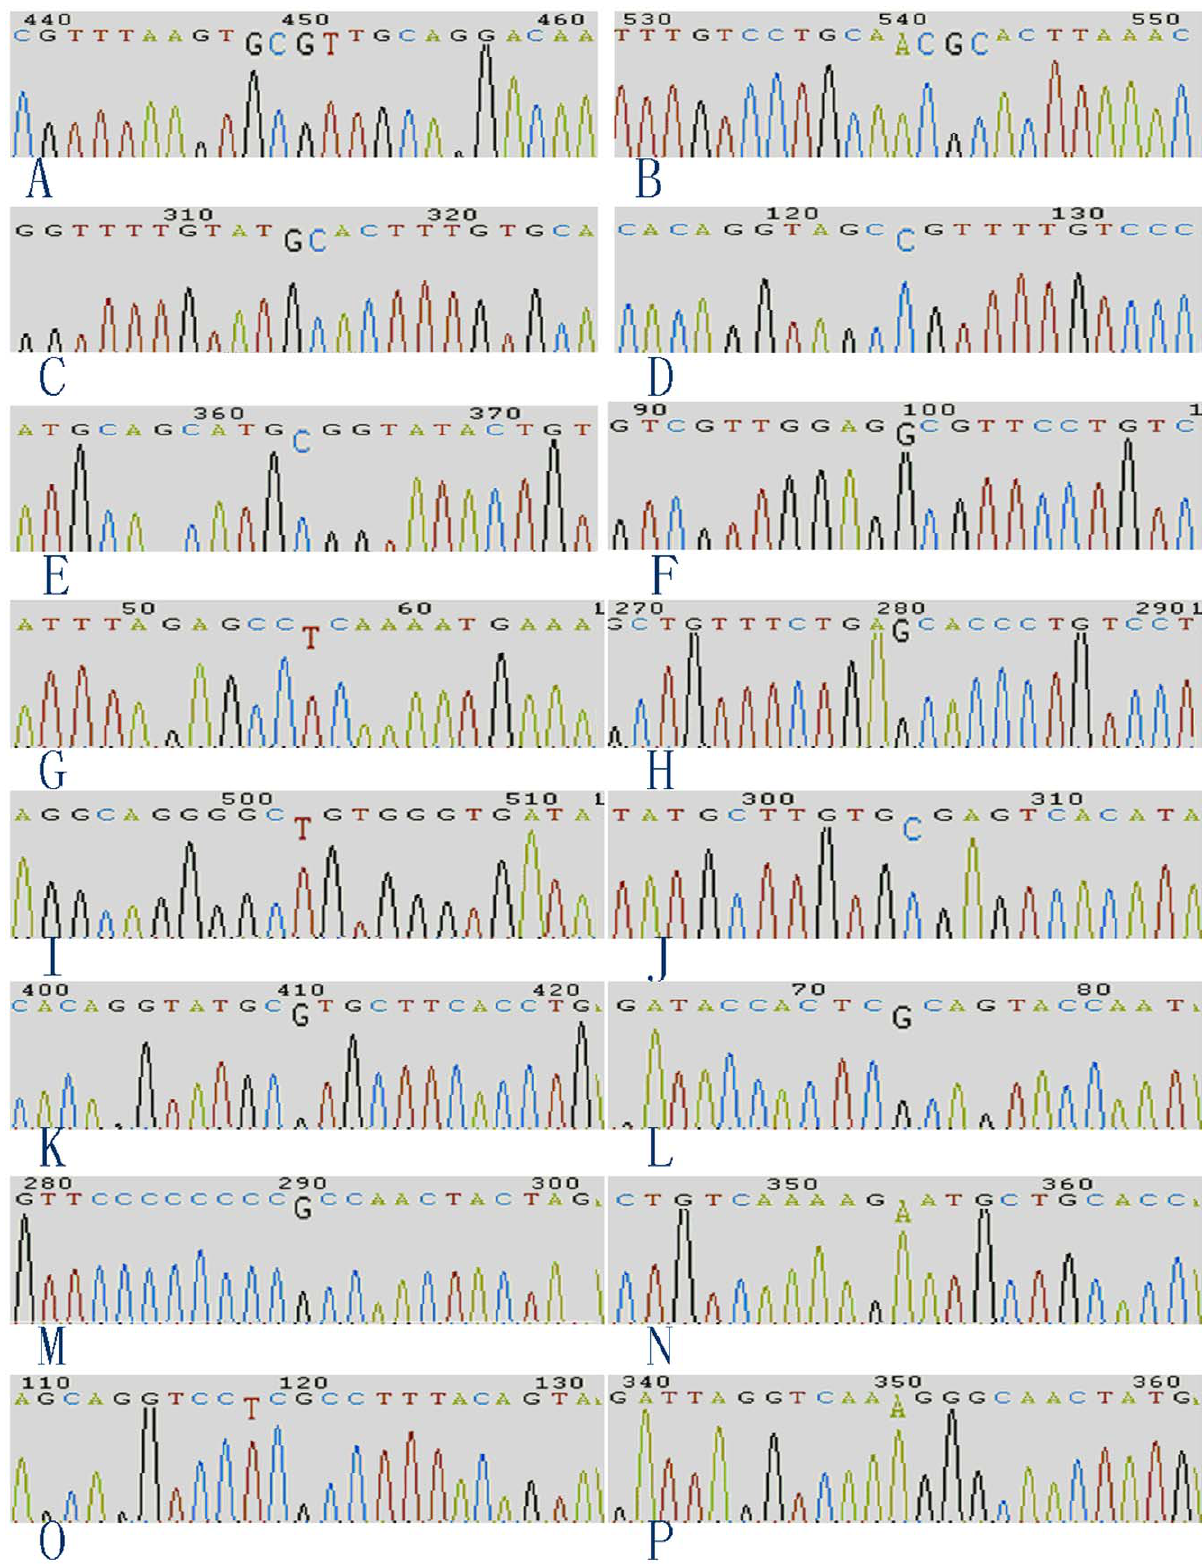
Figure 1. Chromatograms of sequence variations. The sequence variations were enlarged to facilitate observation. In B, D, E, F, I and J, the reverse complement of the sequence variations are displayed because the sequences were obtained using downstream primers. G, guanine; C, cytosine; A, adenine; and T, thymine.